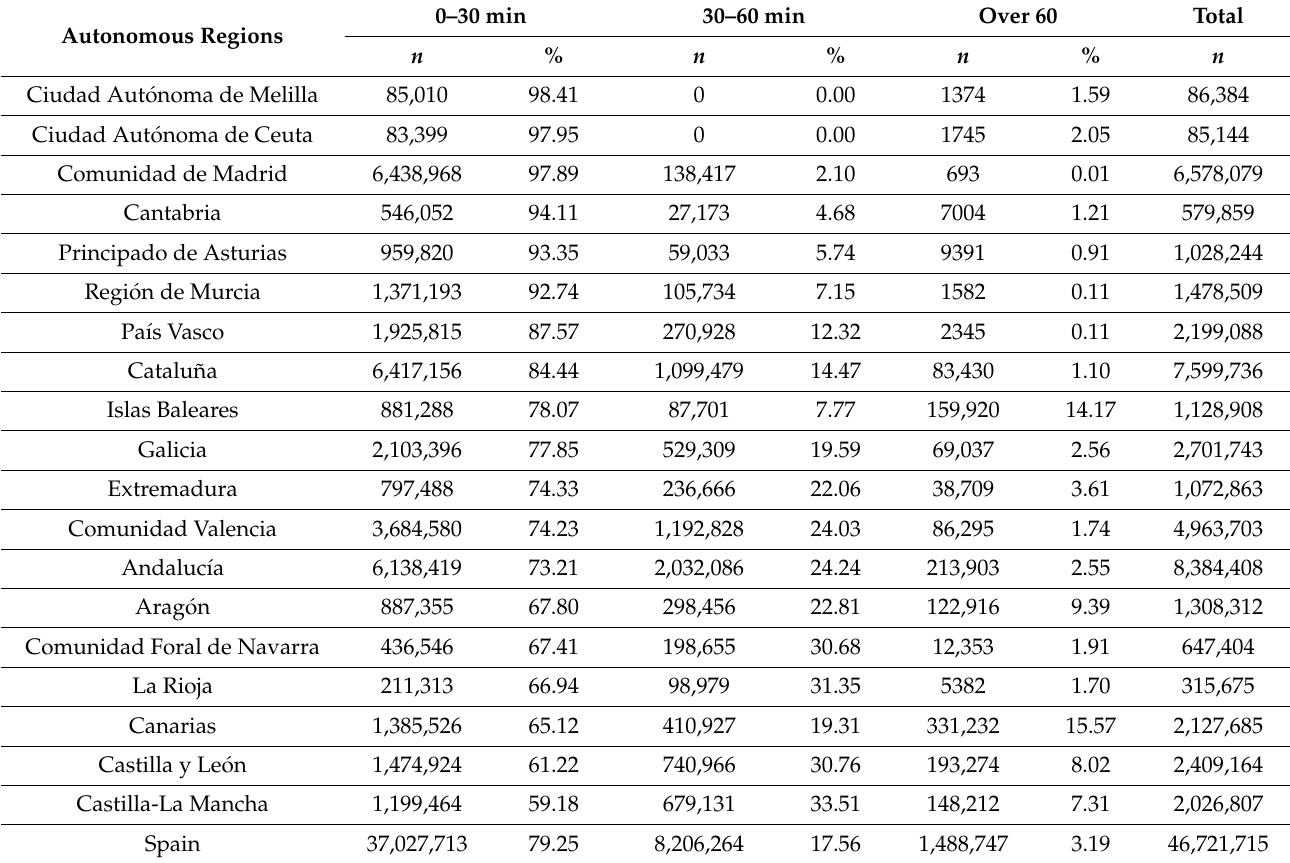
Table 3. Population living in regions with different driving times from the specialized palliative care services across autonomous regions in Spain.